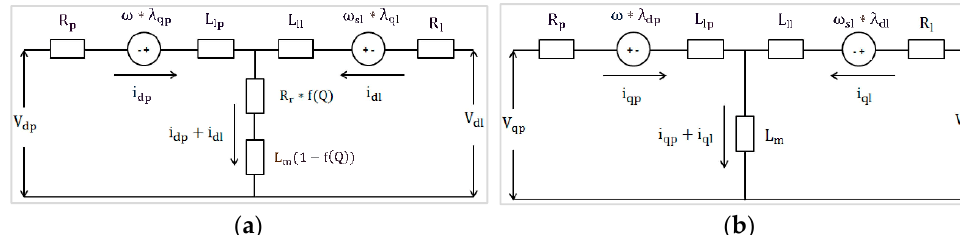
Figure 6. Design workflow.